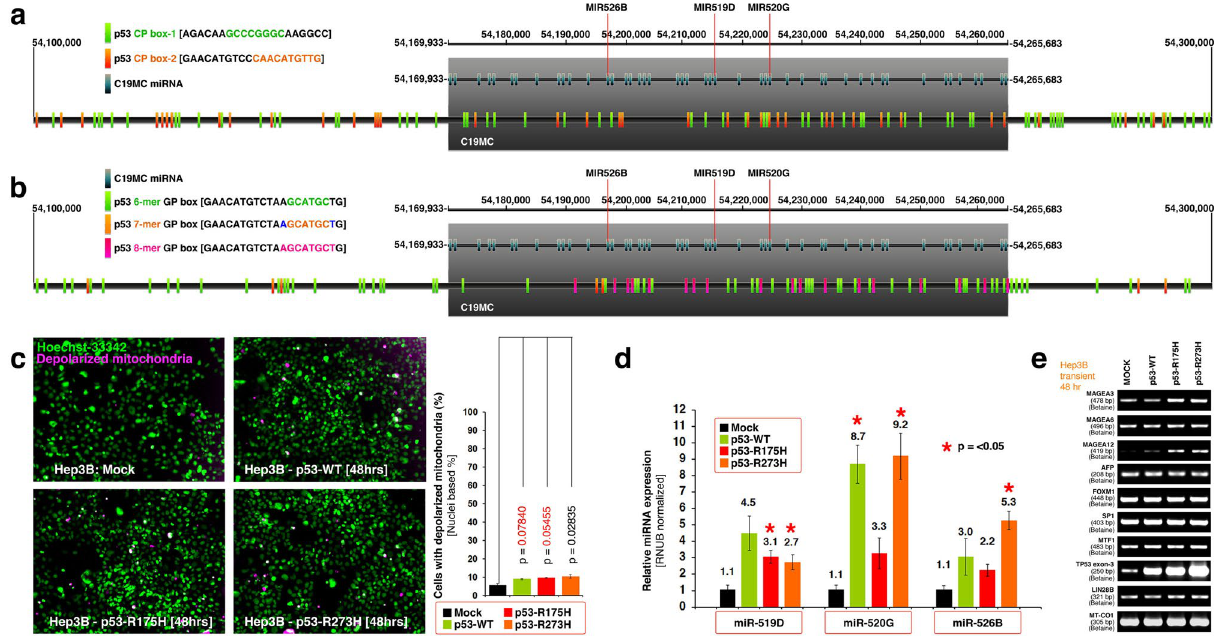
Figure 4. Wild-type and mutant p53s regulate miR-520G and melanoma antigen expression without inducing considerable cell death. ( a ) A map of CDKN1A gene’s p53 binding palindromic boxes-1 (green font/box) and 2 (orange font/box) [CP box] within C19MC (grey box) and surrounding landscapes. 6-mer-to-10-mer palindromic sequences were mapped to a 200 kb region enclosing C19MC. ( b ) A map of GADD45 gene’s p53 binding palindromic box (6-mer palindrome = green font/box), (8-mer palindrome = pink font/box) and (7-mer palindrome = orange font/box with 1 nucleotide match to 8-mer palindrome blue font) [GP box] within C19MC (grey box) and surrounding landscapes. ( c ) Transient transfection of p53-WT or mutant p53s does not induce considerable mitochondrial depolarization in Hep3B cells as evaluated by JC1 and Hoechst-33342 staining. The microscopy images were pseudo-colored as indicated. Purple corresponds to JC1 staining of depolarized mitochondria (MOMP). Also see Fig. 6D-E for more details. ( d ) Transient transfection of p53-WT or mutant p53s induce C19MC miRNA-520G expression in Hep3B cells as evaluated by qRT-PCR and is associated with induction/promotion of MAGEA mRNAs as evaluated by RT-PCR (panel- e